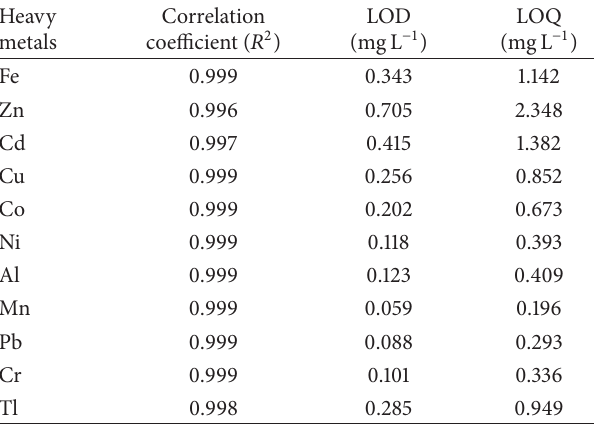
Table 2: The values of correlation coefficients, LOD, and LOQ of examined heavy